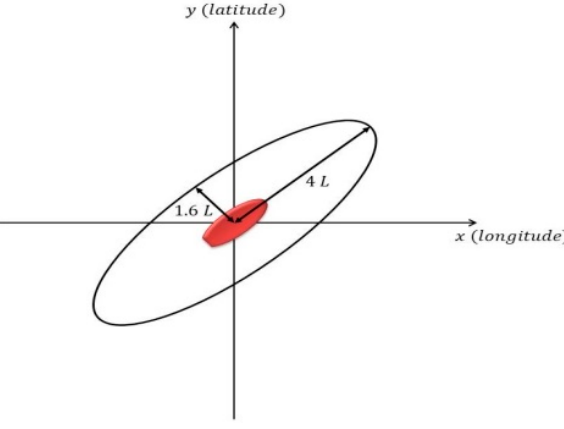
Figure 3. Ship safety domain proposed by Fujii and Tanaka.